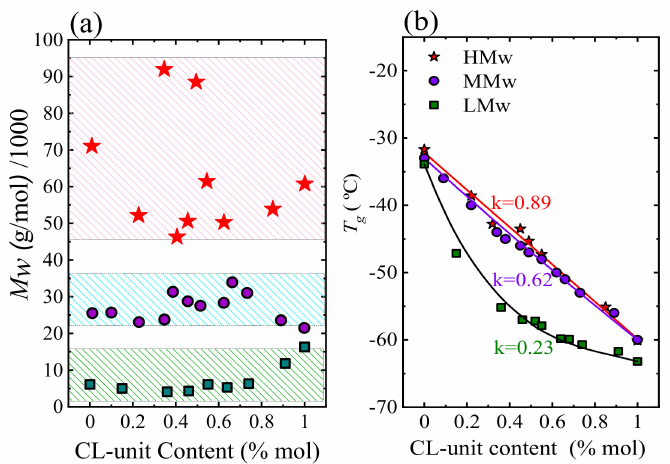
Figure 2. ( a ) M W of samples tested. ( b ) Glass transition temperature values versus composition for three series of copolyesters fitted with the Gordon-Taylor equation. k values are the Gordon-Taylor